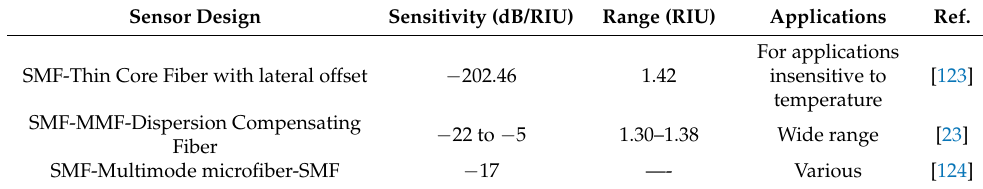
Table 7. Refractive index sensitivity of